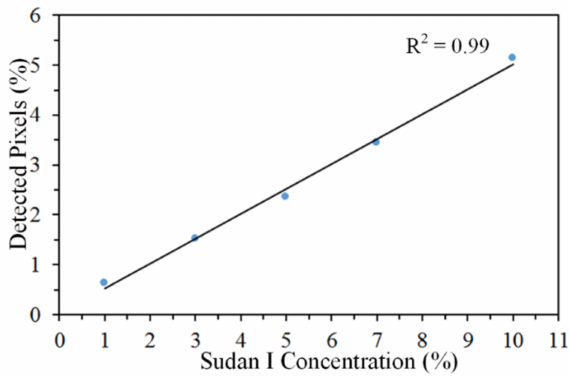
Figure 6. Relationship between Sudan-I concentration in samples and percentage of detected pixels in 1593 cm − 1 binary